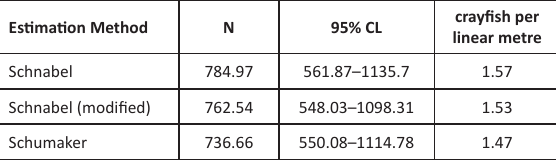
Table 1. Estimates of population density for Euastacus sulcatus from the long-term biological monitoring site at Brindle Creek (site length